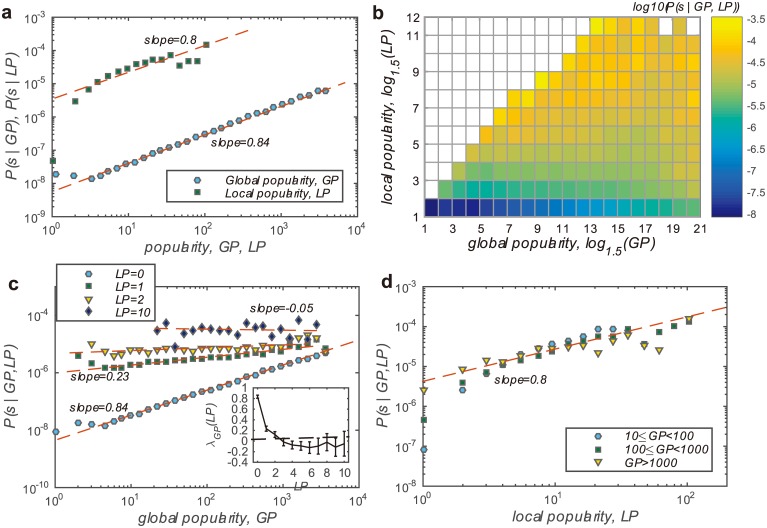
(Color online) a, The probability of being selected conditional to the global popularity and local popularity respectively. The results are plotted in log-log scale. The correlations between the probability and the global/local popularity are fitted by functions with form of P(s|GP)∼GPλ and P(s|LP)∼LPλ. The fitted parameters are λGP = 0.84 and λLP = 0.8 for the global and local popularity respectively. b, A colourmap to describe the probability conditional to global and local popularity, i.e. P(s|GP, LP). There are blanks on the colourmap and it is because no data records satisfy the the condition that GP < LP. c and d, Horizontal and vertical cross sections of the probability shown in subplot b, i.e. the conditional probability with LP and GP controlled respectively. One can still fit the slopes of the linear patterns in the log-log scale. The inset of subplot (c) shows the slope of the fitting λGP(LP) versus the control of local popularity LP.